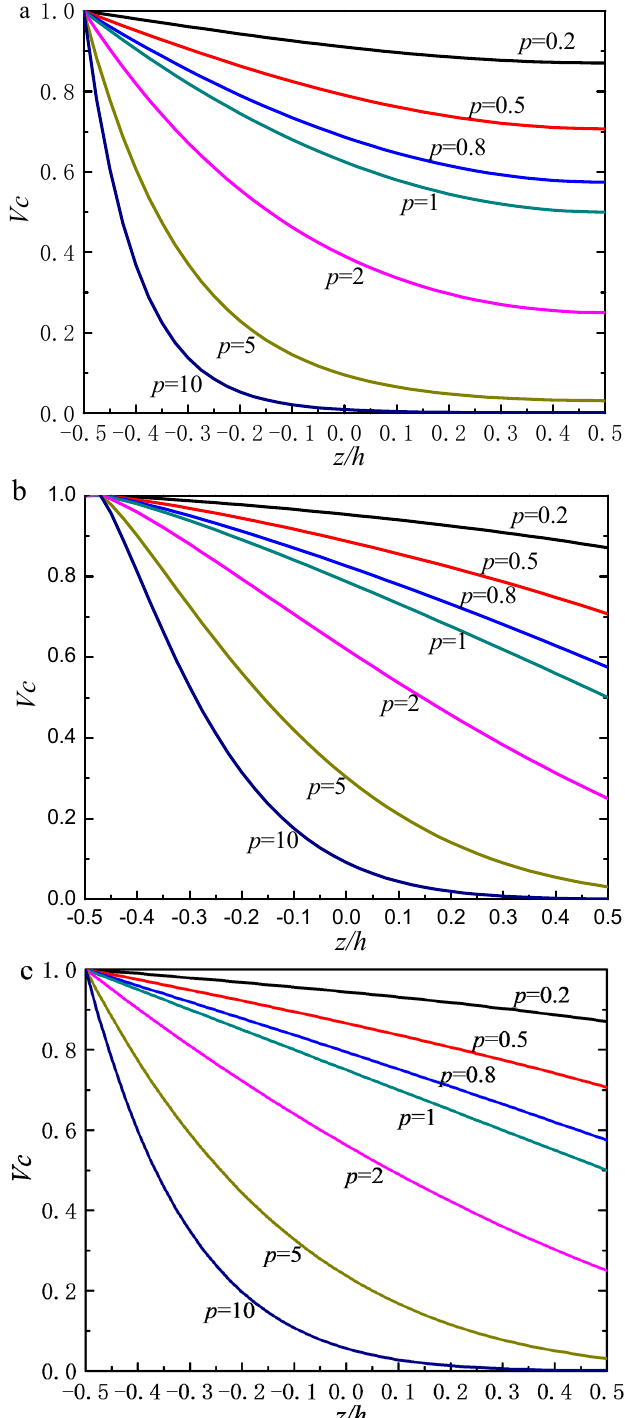
Figure 3. The variations V c about various values of a , b , c and p : ( a ) FGM I ( a = 0; b = 0.5; c = 2; p ); ( b ) FGM I ( a = 1; b = 0.5; c = 0.8; p ); (c) FGM I ( a = 0; b = − 0.5; c = 1; p ).